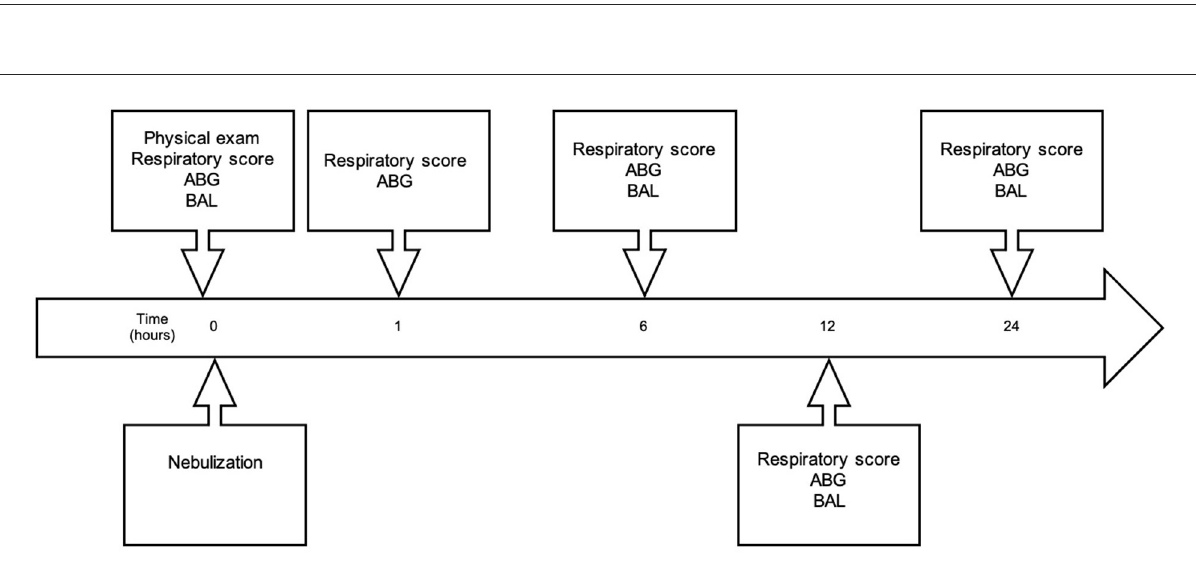
FIGURE2 Timeline of experimental sampling. Immediately prior to nebulization, horses underwent physical examinations and arterial blood gas (ABG) sampling, and received baseline respiratory scores and bronchoalveolar lavage (BAL). Nebulization was then performed, and respiratory scores and ABG were repeated 1-h post completion of nebulization. Respiratory scores, ABG analysis, and BAL were repeated at 6-, 12- and 24-h post